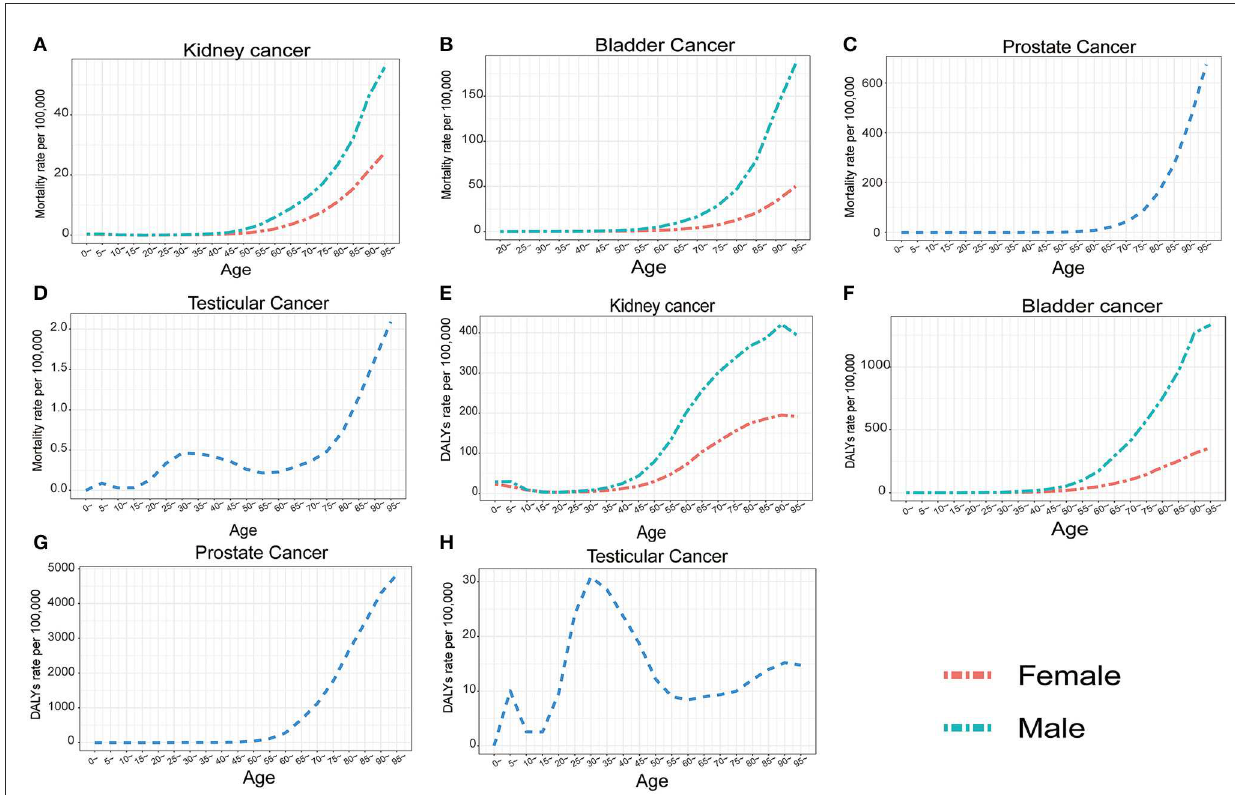
FIGURE5 The change of global mortality rate and DALY rate per 100,000 people with age for kidney cancer (A, E) bladder cancer (B, F) prostate cancer (C, G) and testicular cancer (D, H) for both sexes in 2019.